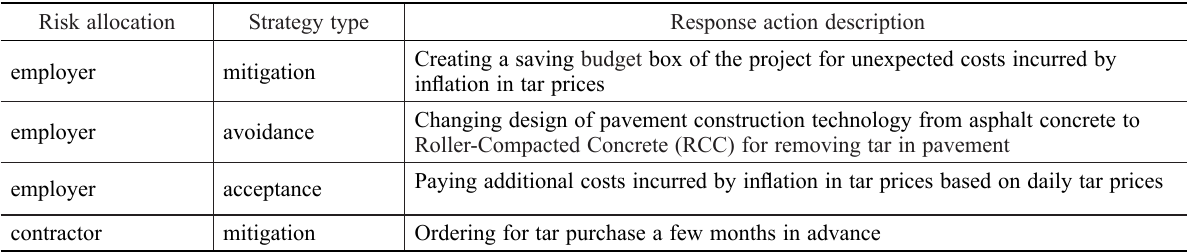
Table 4. Possible response actions to the risk event of “increase in tar price”